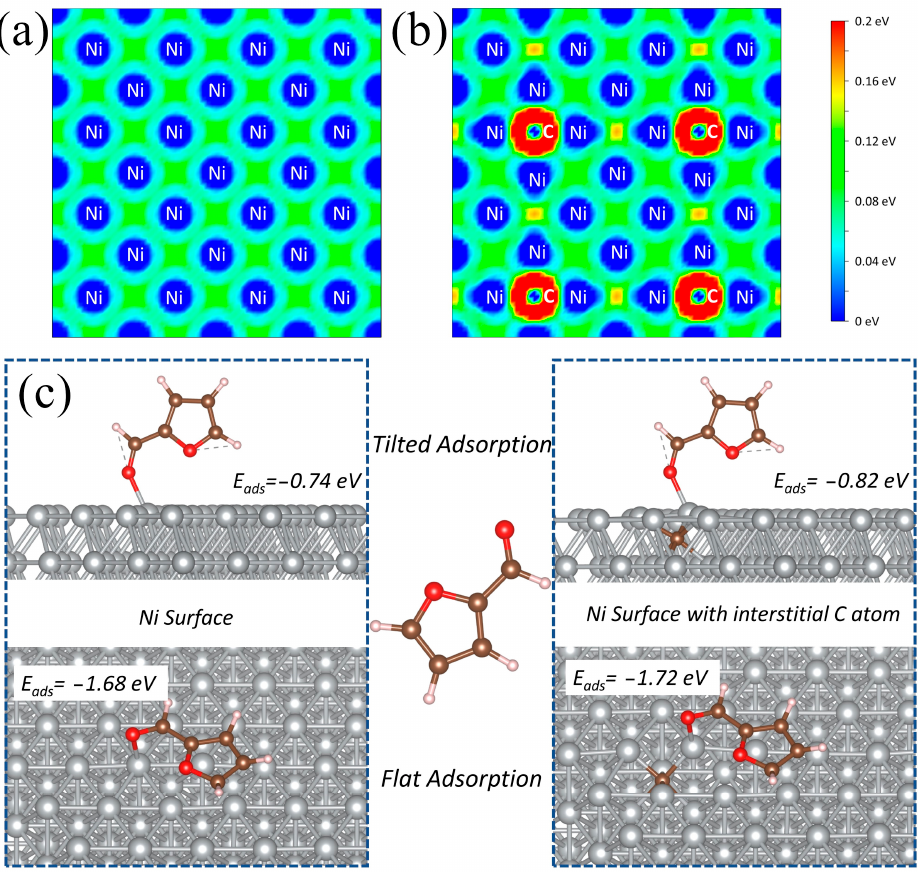
Figure 6. Charge density difference plots of ( a ) Ni and ( b ) Ni with interstitial carbon, ( c ) adsorption energies of different furfural adsorption configurations on the surface of Ni (111) with and without interstitial